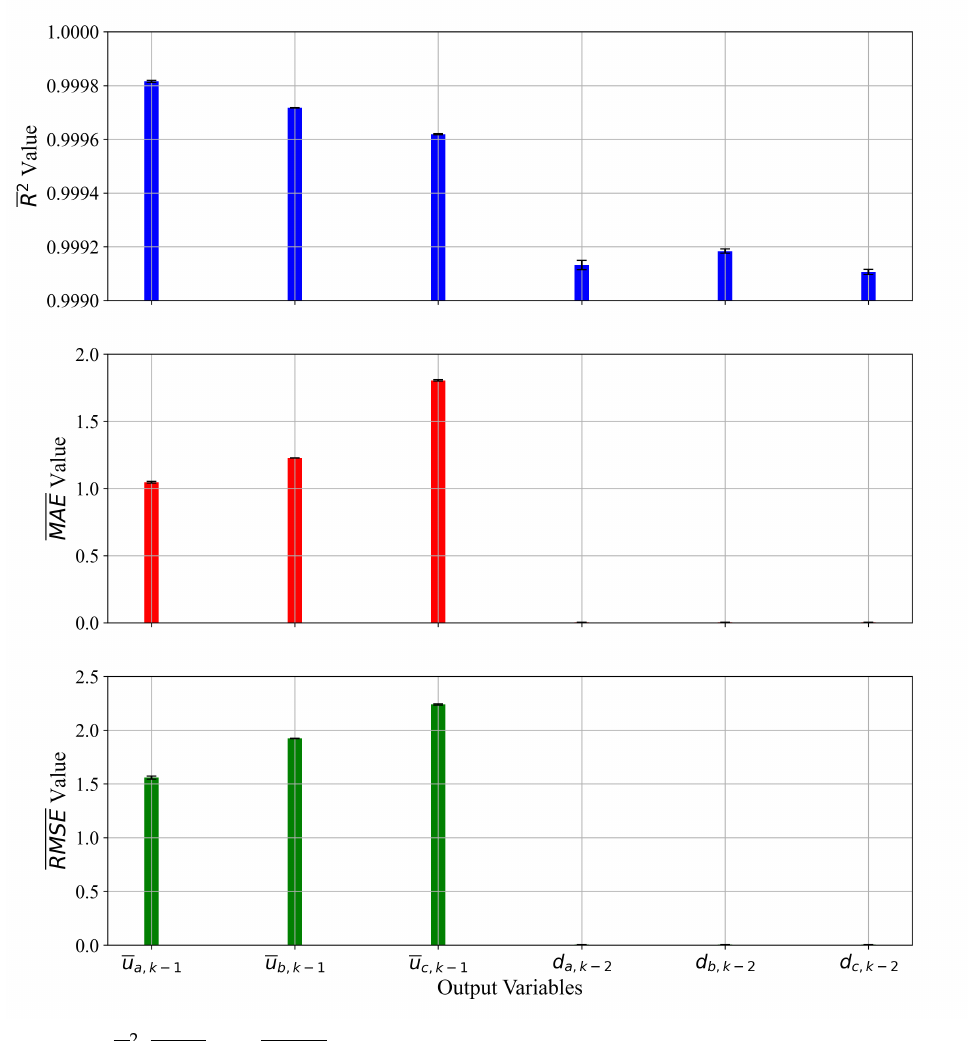
Figure 11. R 2 , MAE , and RMSE values for each output variable with standard deviation